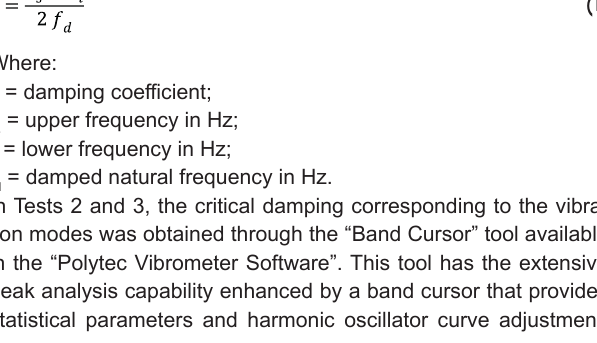
and the vibration exciter (Shaker) for this modal analysis test. The experimental FFT magnitudes of the pedestrian footbridge mode shapes are described by Figure 10.